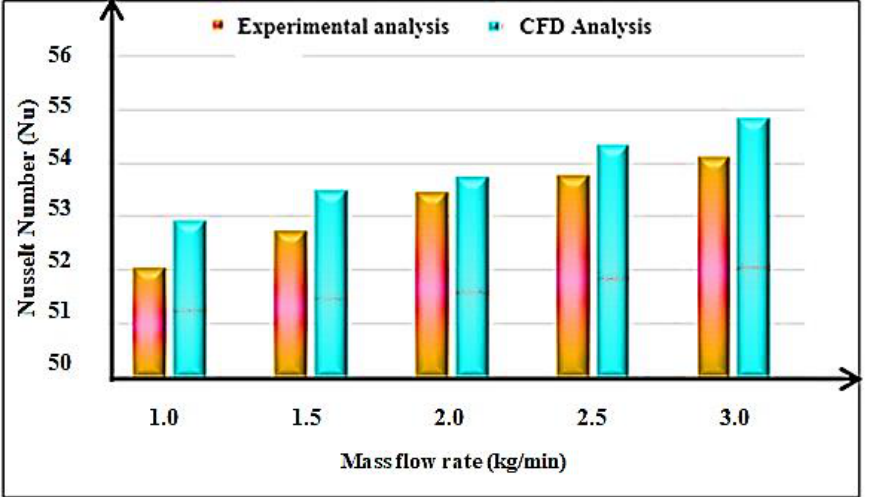
Figure 10. Evaluation of Nusselt number.